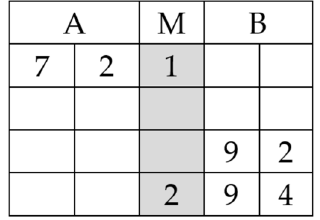
Figure A2. Example of score notation.